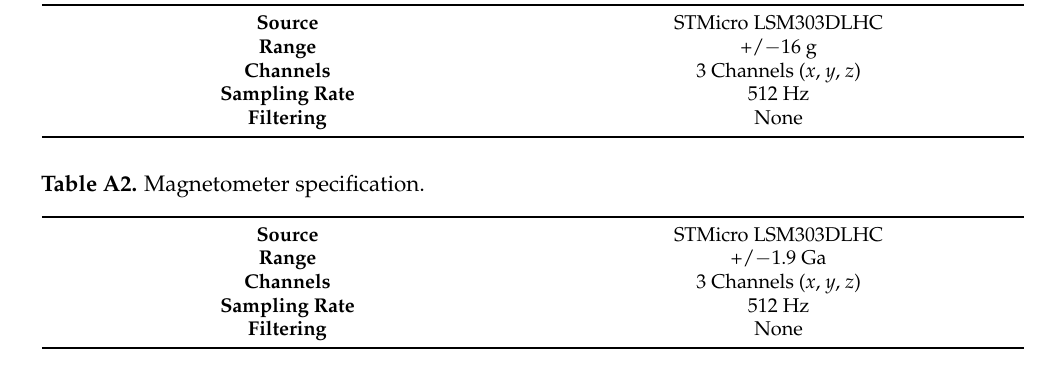
Table A3. Gyroscope specification.